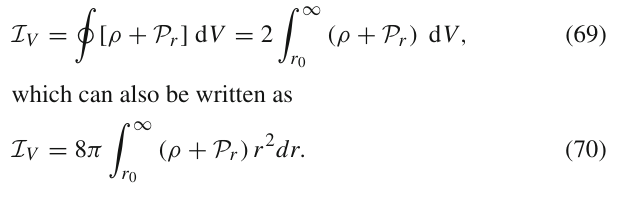
# (ρ( r ) + P ( r )) d V , where d V = r 2 sin θ d r d θ d φ . In r